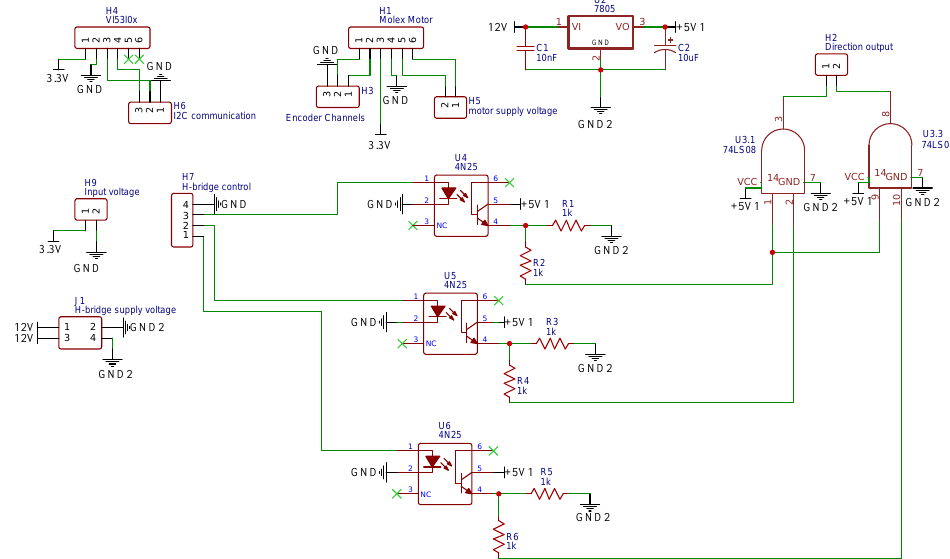
Figure 5. Development board